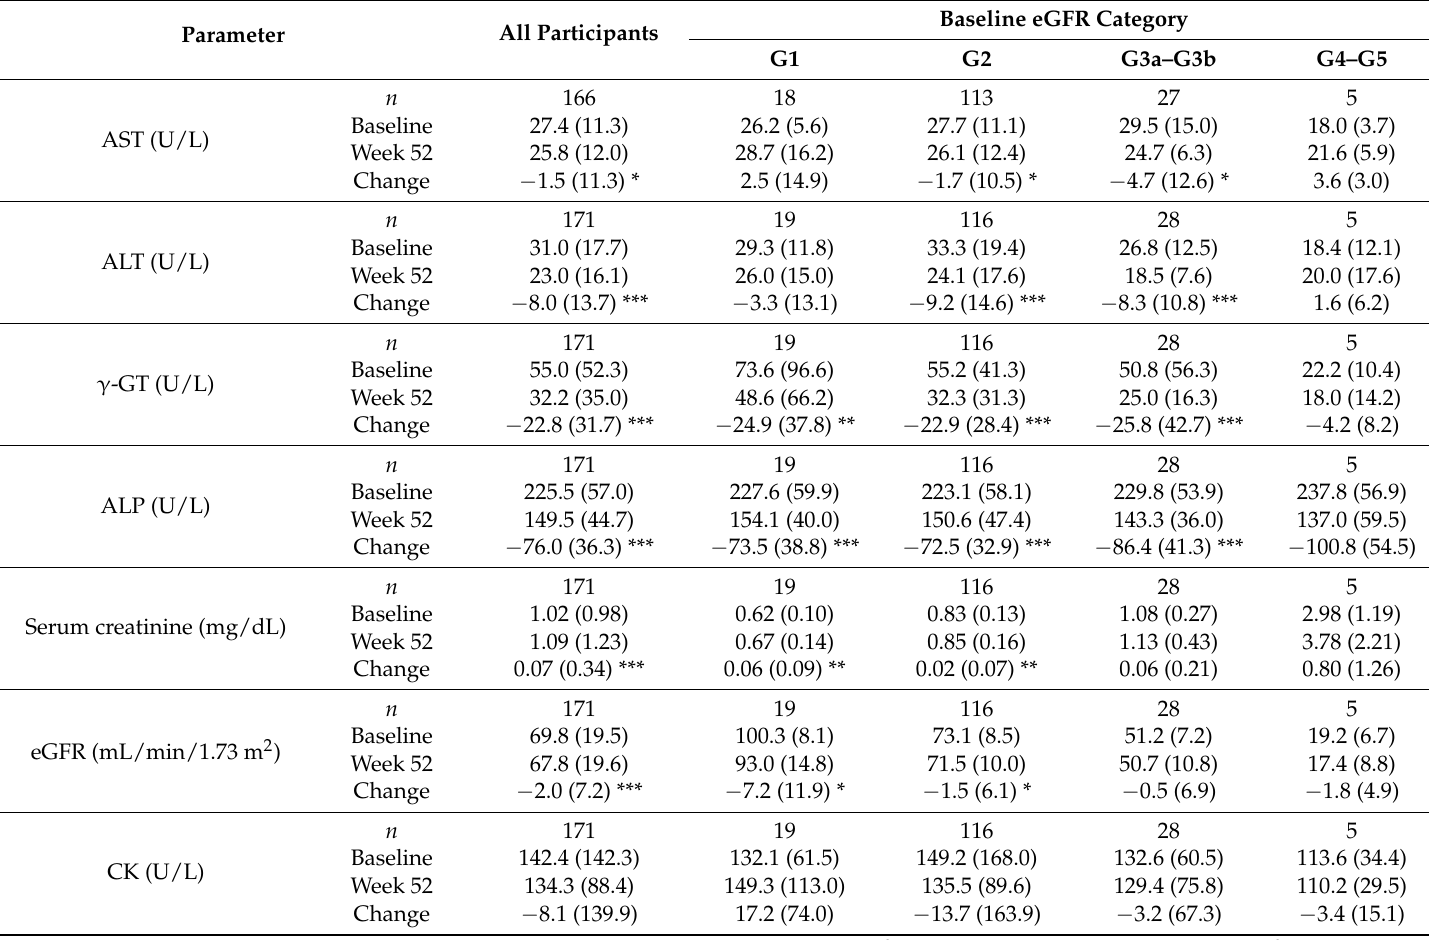
Table 6. Changes from baseline in the levels of safety